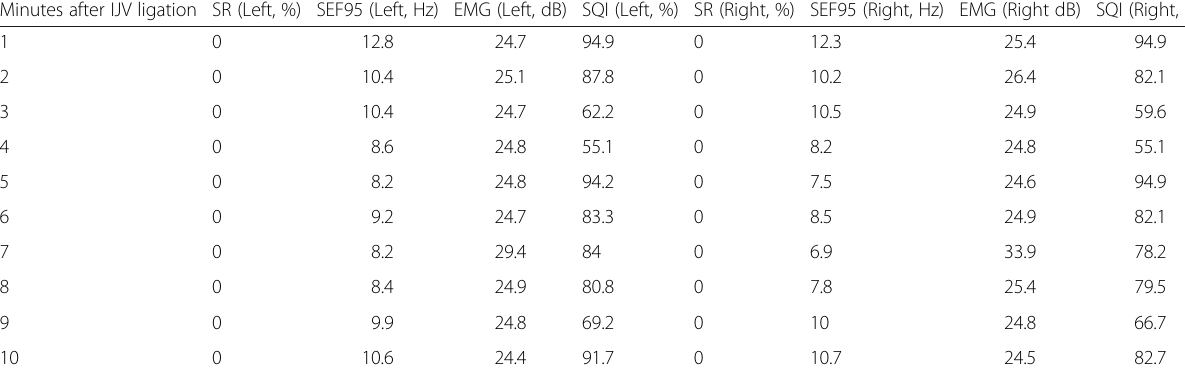
Table 1 Additional data of BIS values after ligation of the IJV. Changes in suppression ratio (SR), spectral edge frequency 95 (SEF95), electromyography (EMG) and signal quality index (SQI) 10 min after the internal jugular vein (IJV) ligation are shown Minutes after IJV ligation SR (Left, %) SEF95 (Left, Hz) EMG (Left, dB) SQI (Left, %) SR (Right, %) SEF95 (Right, Hz) EMG (Right dB) SQI (Right,